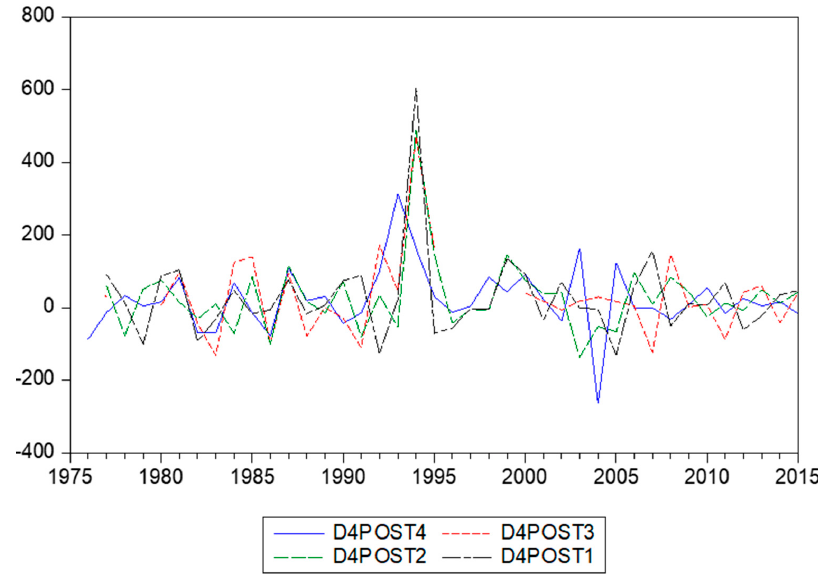
Figure 6. Annual changes in stamps prices, observed per quarter, for MIDAS regression.